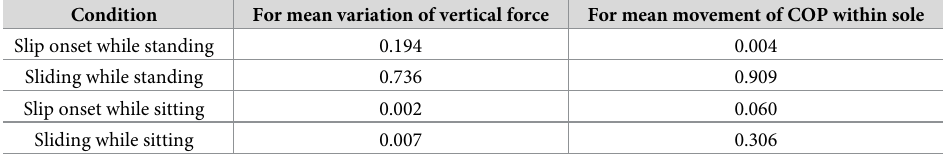
Table 9. Probability values in Mann-Whitney’s U test between participants with friction perception capability and